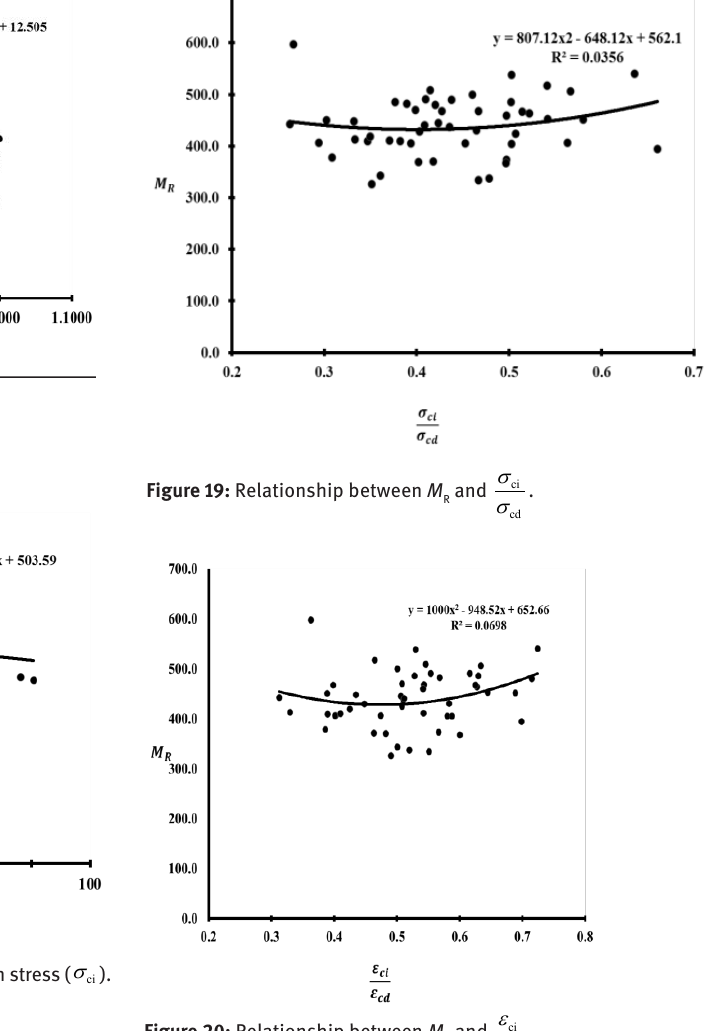
Fig. 21. Relationship between